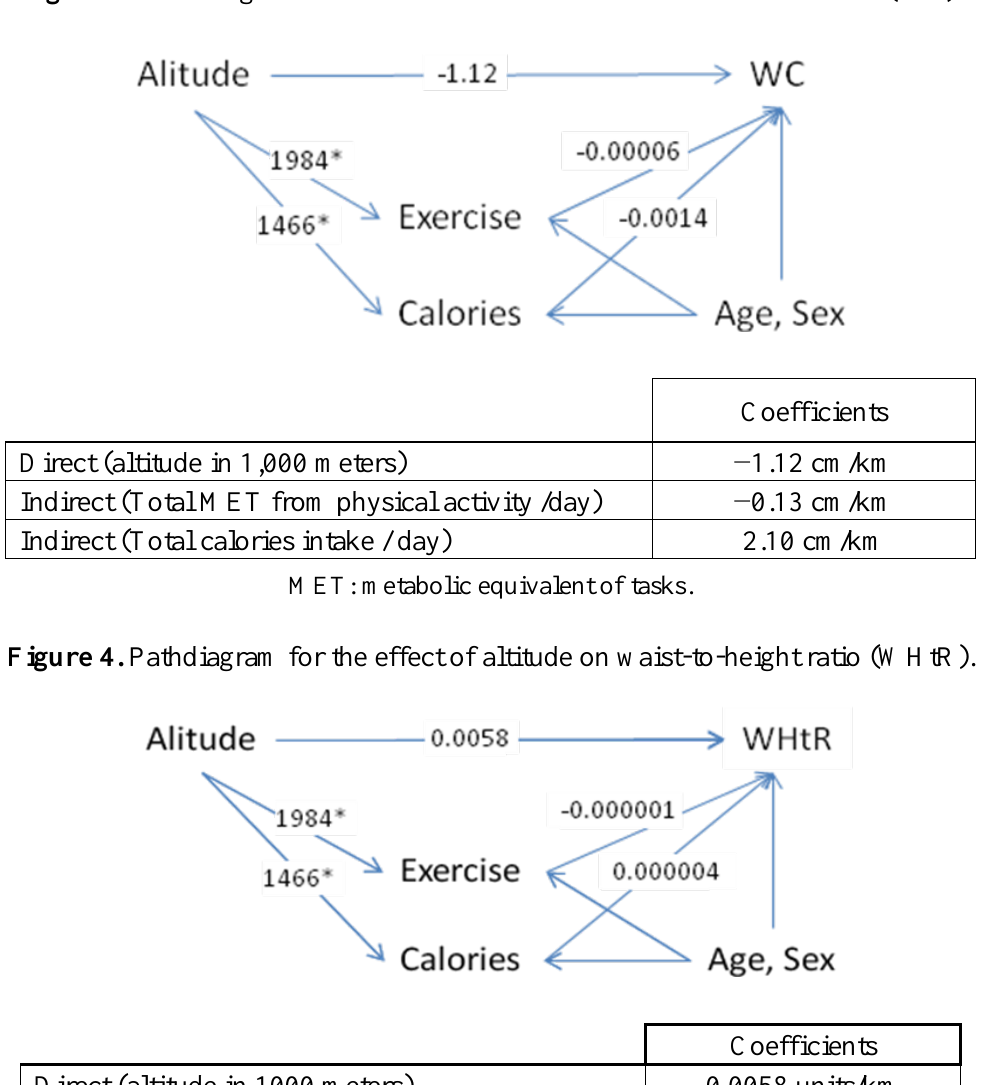
Figure 3. Path diagram for the effect of altitude on waist circumference (WC).